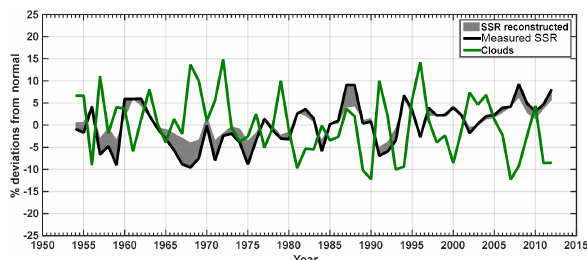
Figure 7. De-seasonalized yearly percent deviations from mean for SSR (black line) and cloud octas. Grey lines show measurements with possible uncertainties/drifts.